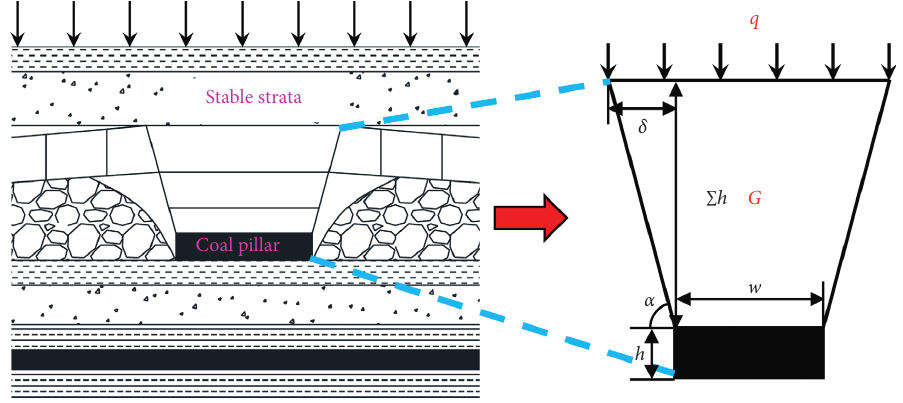
Figure 6: Schematic diagram of coal pillar static